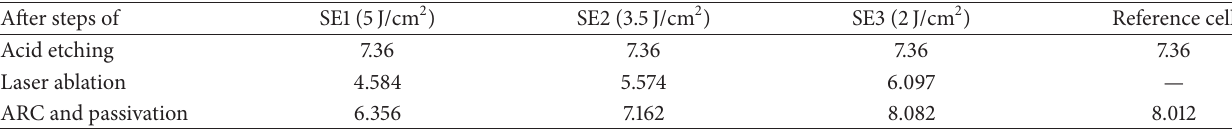
Table 1: The variation of the average lifetimes ( 𝜏 , in 𝜇 s) of mc-Si wafer corresponds to different processes for laser fluences (J/cm 2 ) of 5, 3.5, 2, and 0 (as a Ref. cell) after steps of acid etching, laser ablation, ARC, and passivation. The average lifetimes for the acid etching step of all samples are 7.36 𝜇